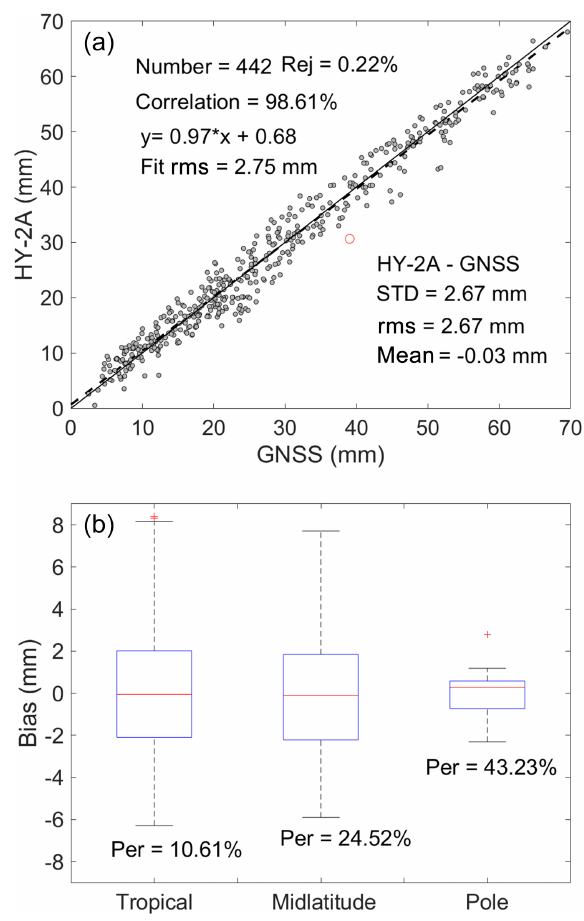
Figure 5. PWV difference between HY-2A and ground GNSS. Panel (a) shows PWV scatter diagram of HY-2A observations and GNSS results; the linear fit result is the solid line, and the dashed line is the reference line; red circles are outliers. Panel (b) shows boxplots of the difference between HY-2A and GNSS at tropical re- gions, midlatitude regions, and pole regions. The blue box describes the upper and lower quartile; the red line inside the box is median value; the whiskers are 1.5 times the interquartile range (IQR), and the red open crosshatches describe data outliers; ”Per” represents the average ratio of the rms to derived PWV of the